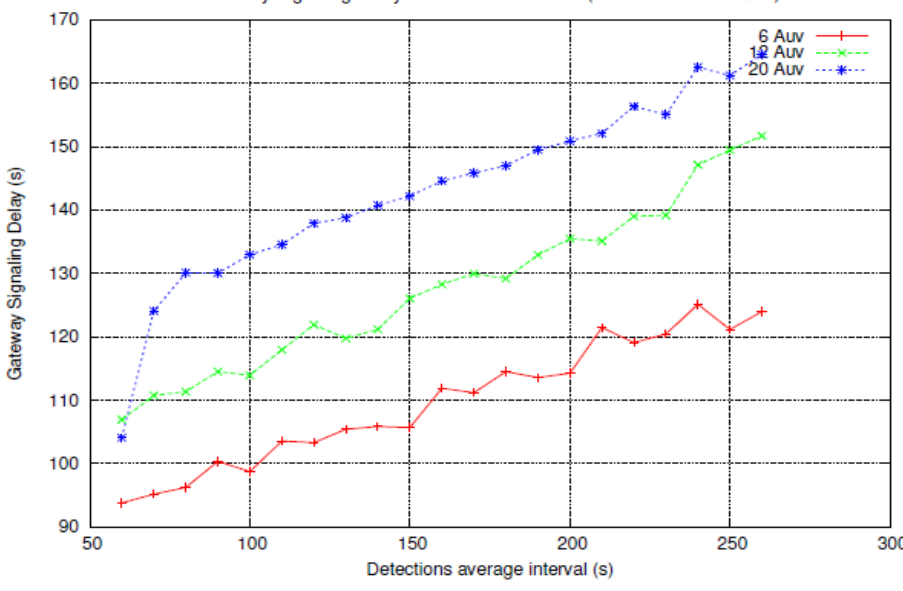
Figure 8. Average Surface Gateway signalling delay against detection interval, for different number of nodes.